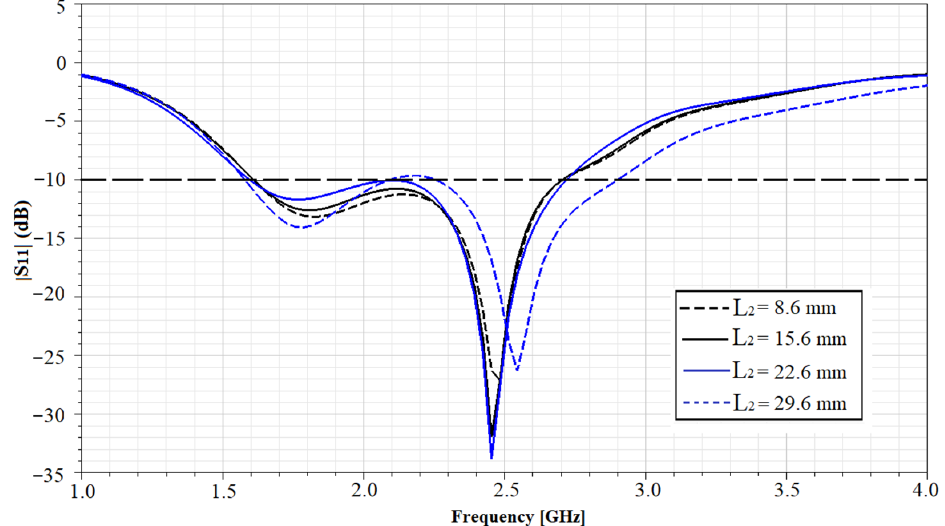
Figure 4. Variation of reflection coefficient |S 11 | with respect to the length L 2.